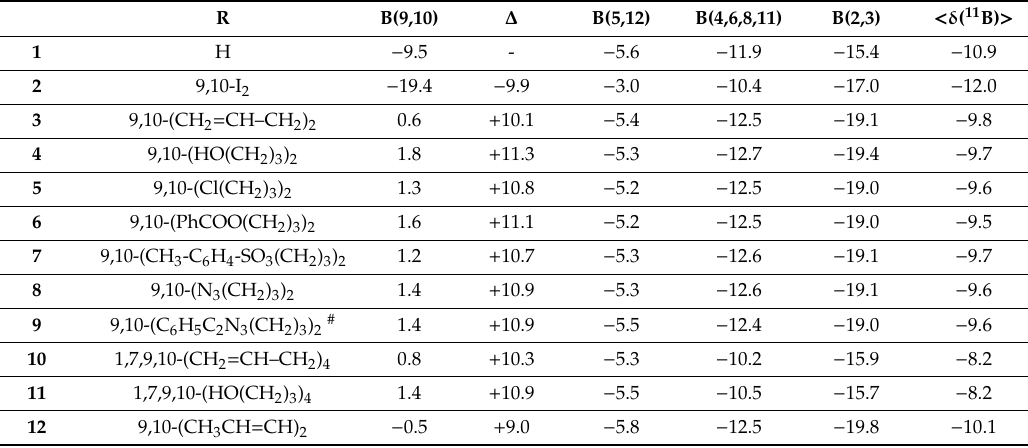
Table 3. 11 B{ 1 H} NMR chemical shifts (in ppm) of di-branched ( 2 – 9 and 12 ) and tetra-branched ( 10 and 11 ) m -carborane derivatives. < δ ( 11 B) > corresponds to the weighted average 11 B{ 1 H} NMR spectrum (in ppm). Spectra were recorded in (CD 3 ) 2 CO and referenced to external BF 3 .Et 2 O unless noted otherwise: # (CD 3 ) 2